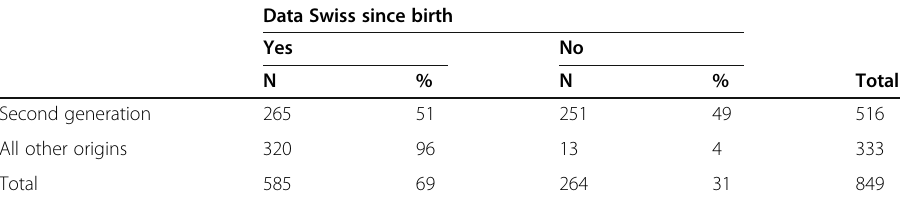
Table 6 Second-generation response to ‘ Swiss since birth ’